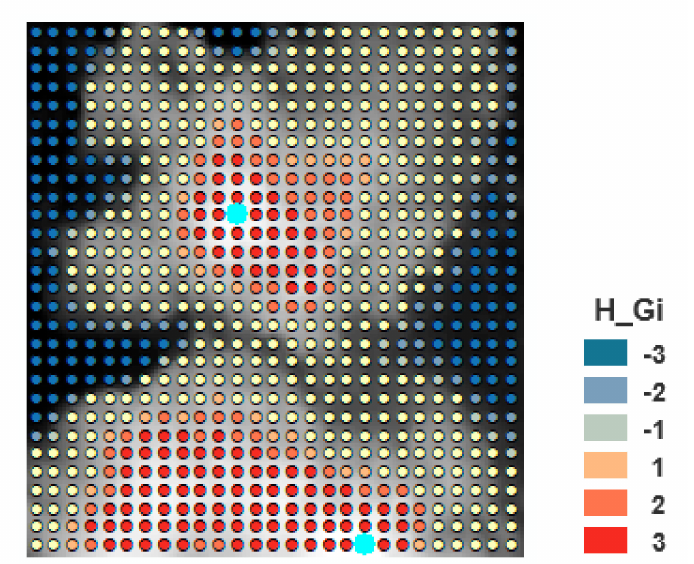
Figure 31. The distribution map for the sixth dataset using our proposed